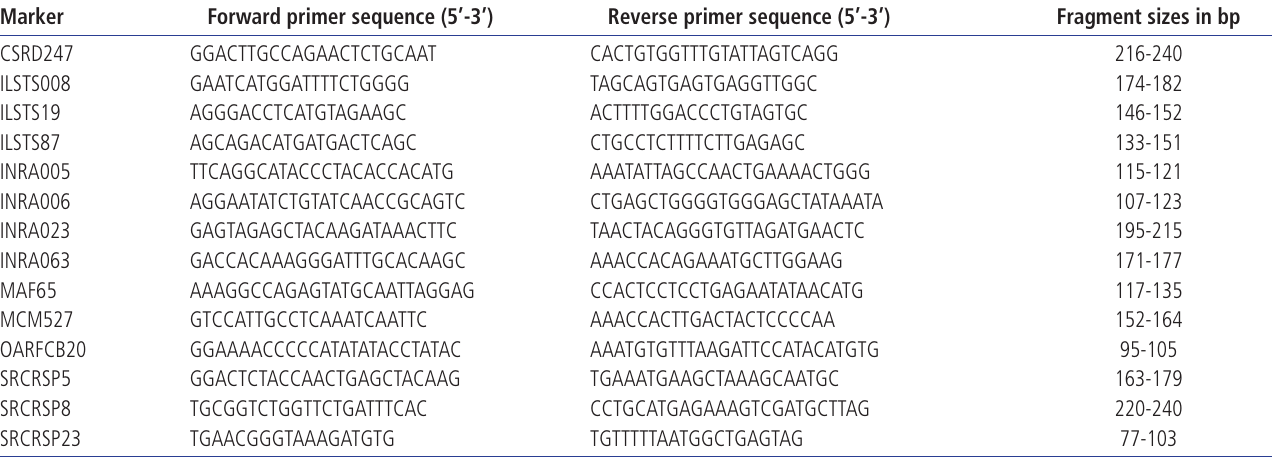
Table 2. Microsatellites panel primers for parentage testing in goats